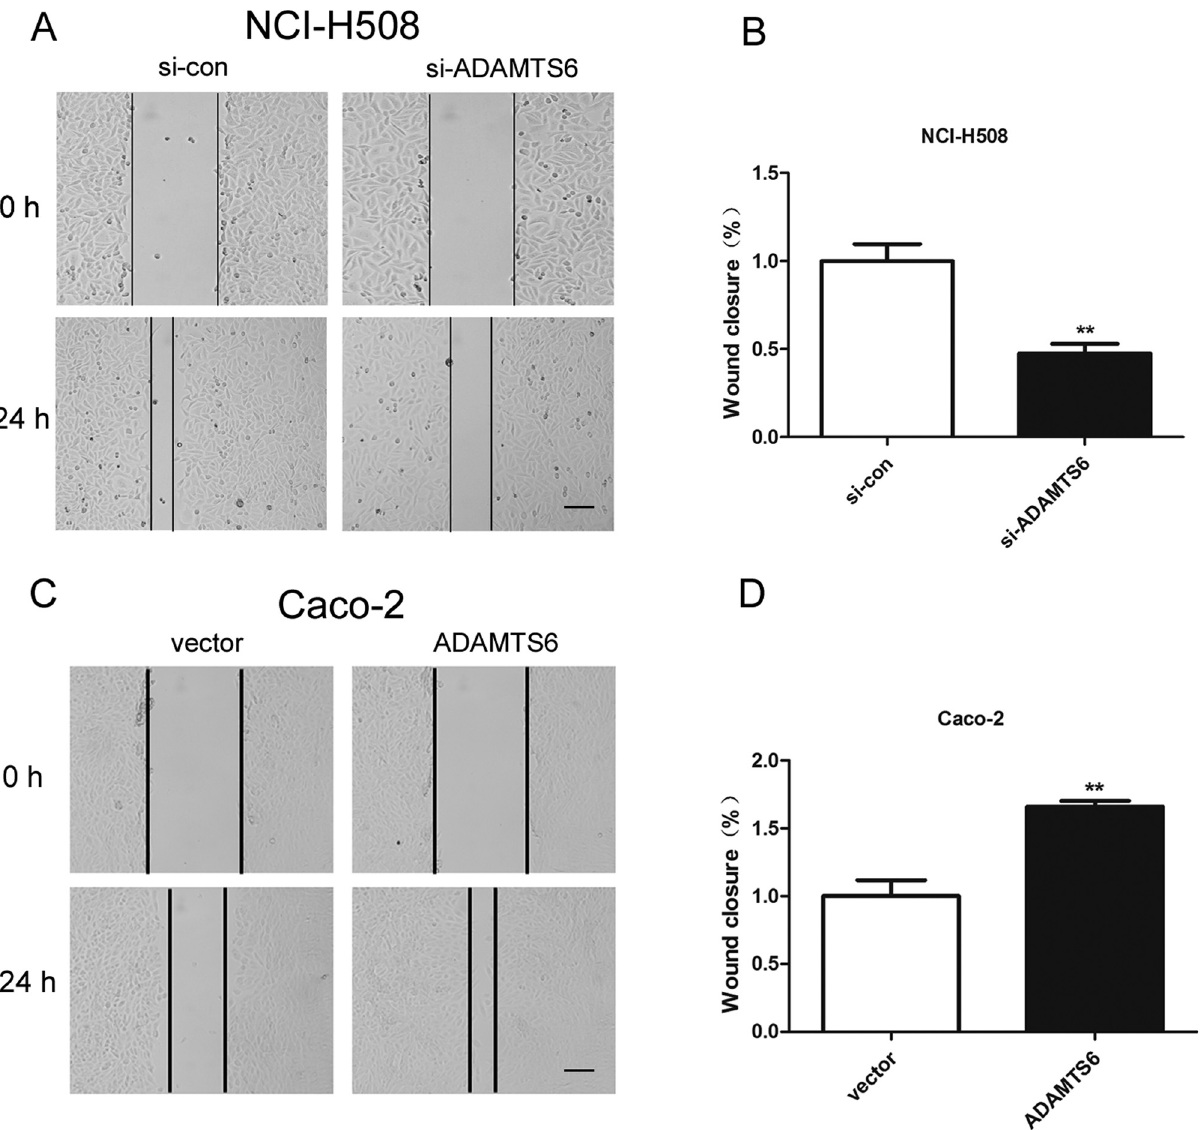
Figure 5 - ADAMTS6 facilitated colon cancer cell migration in wound-healing assay. (A) Cell culture images of the wound healing assay in each group were acquired by microscopy at 0 and 24 h after scratching (bar = 200 (cid:3) m). (B) Wound closure analysis displayed the impact of ADAMTS6 depletion on NCI-H508 cell migration. **P <0.01 vs. si-control group. (C) Cell culture images of the wound healing assay in each group were gained by microscopy at 0 and 24 h after scratching (bar = 200 (cid:3) m). (D) Wound closure analysis showed the influence of ADAMTS6 overexpression on Caco-2 cell migration. **P <0.01 vs. vector